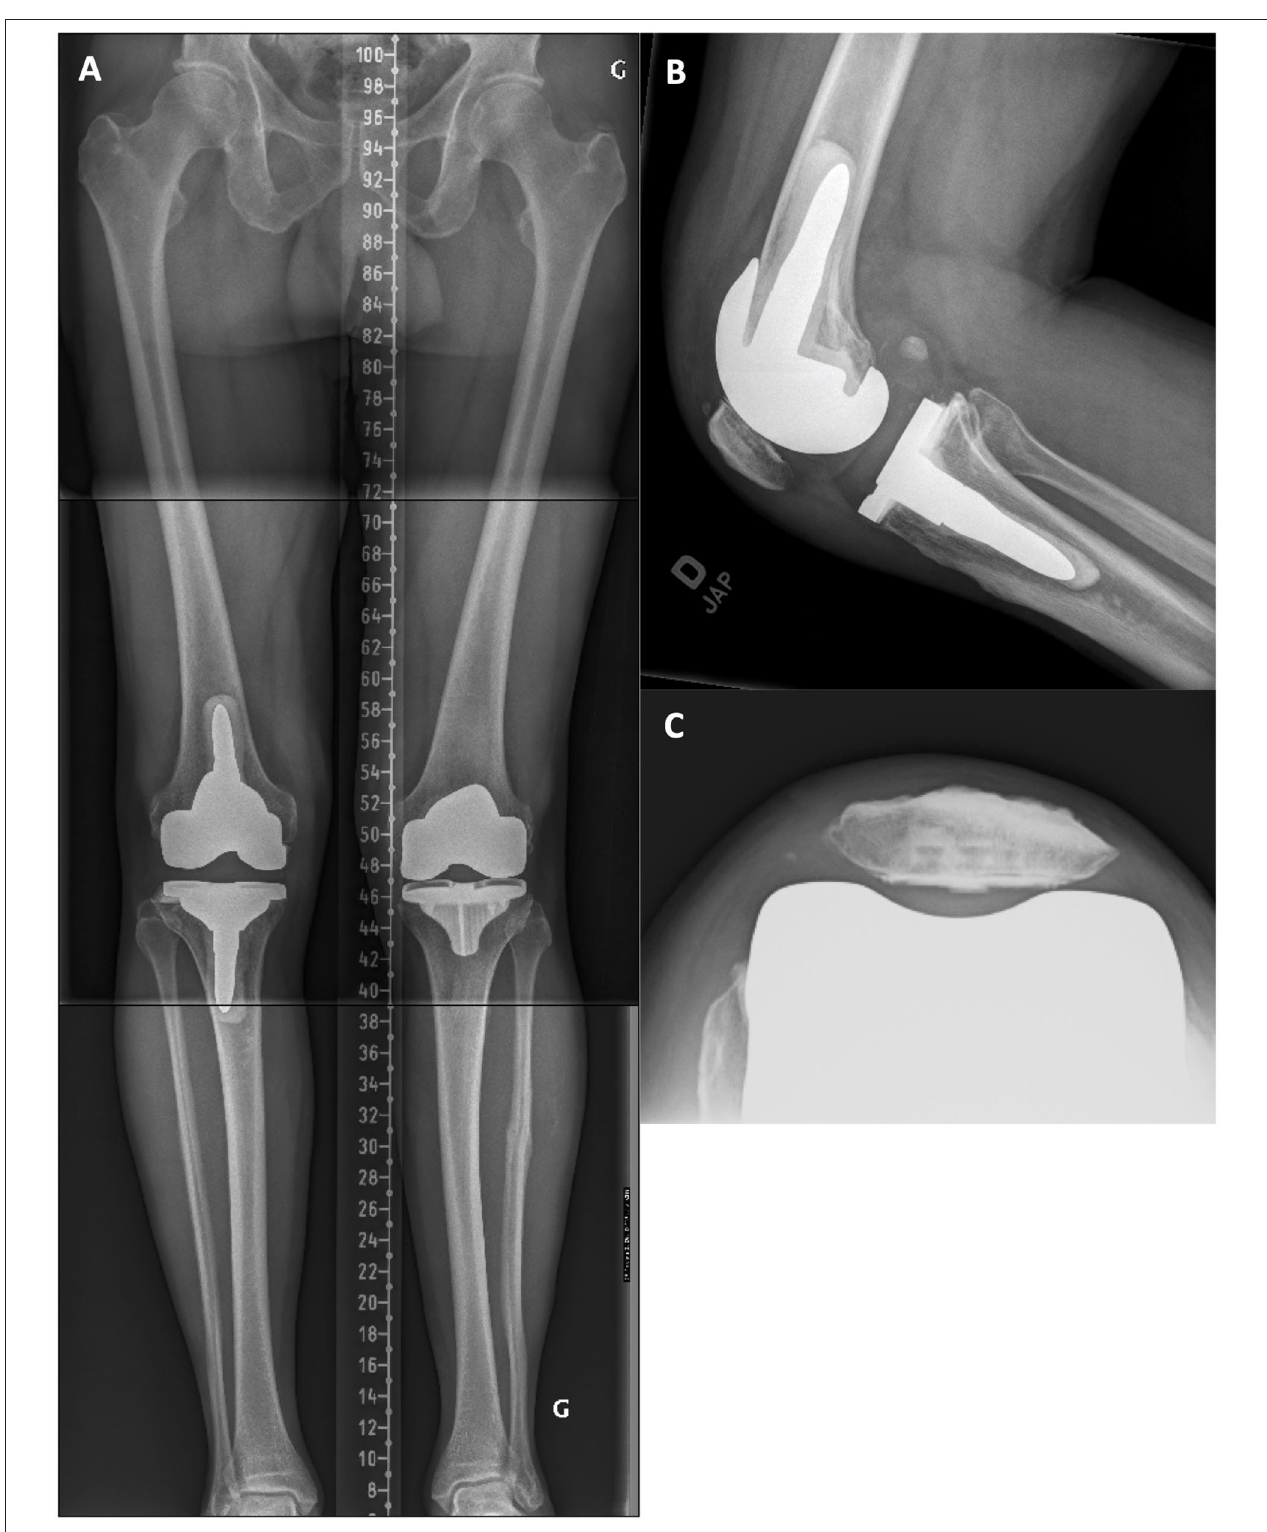
FIGURE 4 | (A) Post-revision standing long-leg X-ray of the right lower limb where the implant mDFA has been modified to 3.0 ◦ valgus and the mPTA at 4.0 ◦ varus (1.0 ◦ varus aHKA). As expected, the 50mm cemented stems are not aligned with the tibial and femoral bone diaphysis and comes in contact with the lateral cortex on the tibial side. (B) Right knee lateral view where the implant posterior tibial slope has been corrected to 2.0 ◦ . (C) Right patella skyline view showing a well-centered implant.